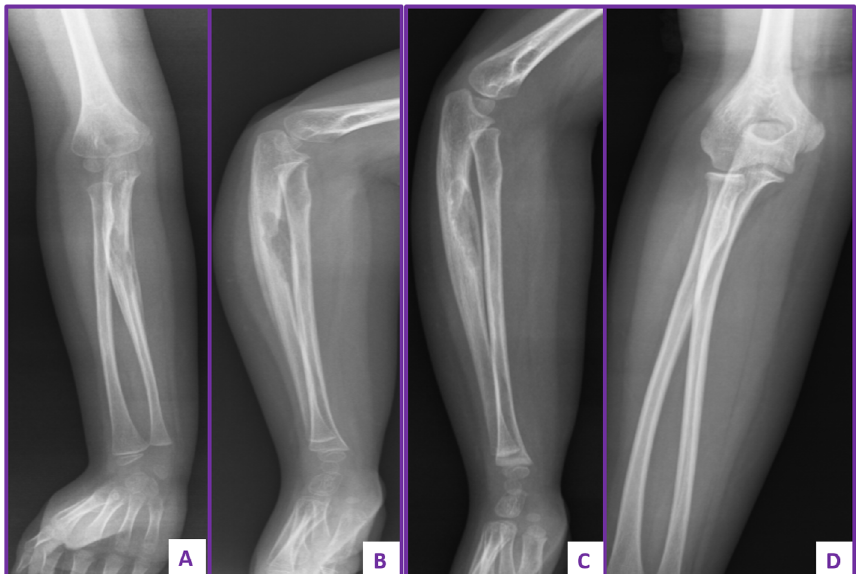
Figure 4. Plain radiograph of forearm of a 5-year-old girl diagnosed with LCH showing large osteolytic lesion of the ulna managed conservatively. (A and B) Anteroposterior and lateral views showing the large sized osteolytic lesion of the ulna. (C) Follow-up after two years showing partial remodeling. (D) Follow-up radiograph showing complete